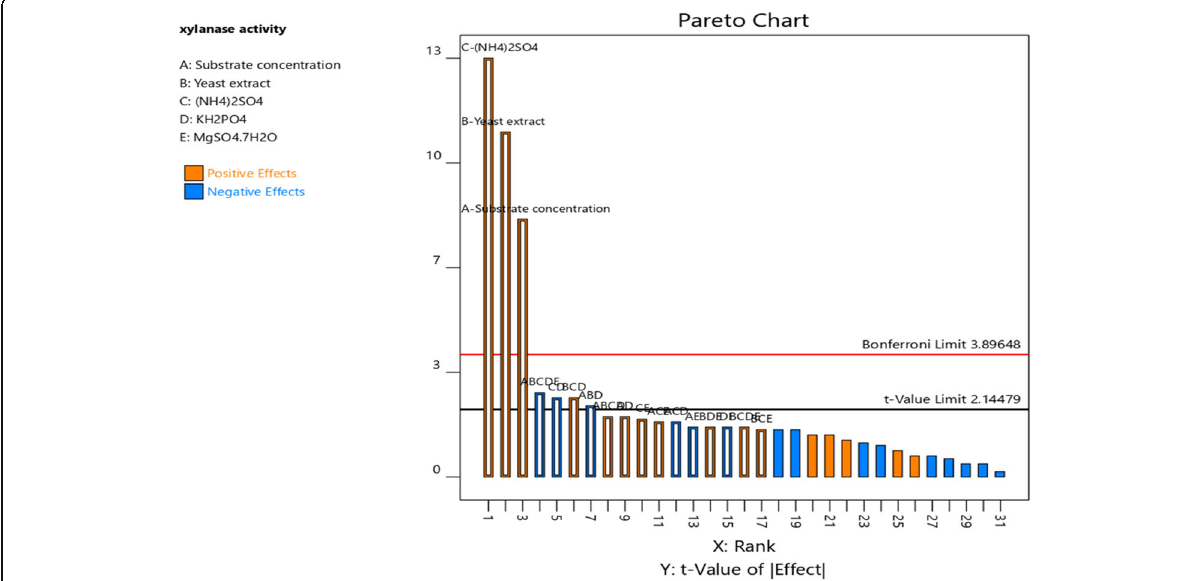
Fig. 3 Experimental xylanase activity contrasted with the predicted xylanase activity under the optimum fermentation